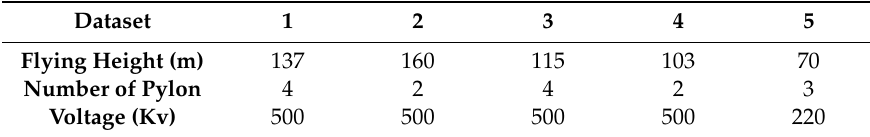
Table 1. Detailed information for flight configuration.